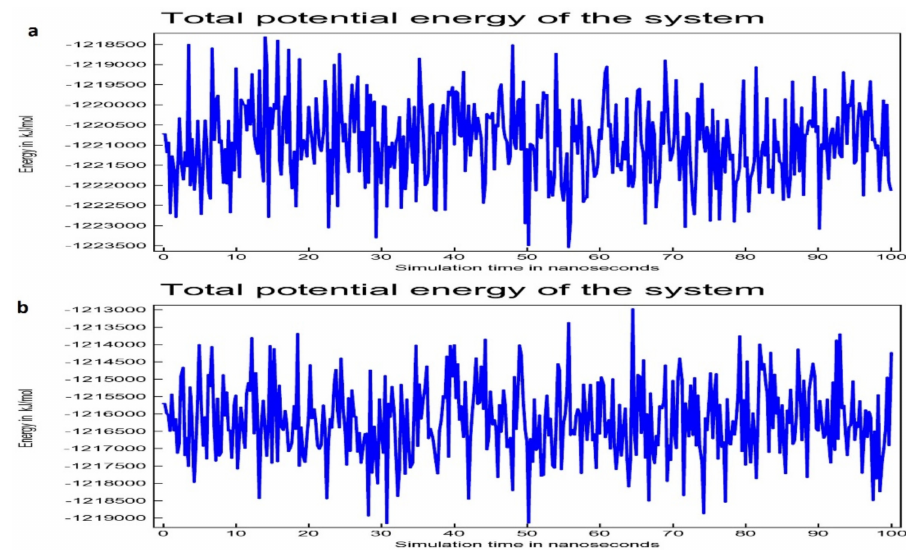
Figure 3. Plot of total potential energy of the system for ( a ) DTQ-3CLpro complex ( b ) DTQ-NSP15 complex versus simulation time of 100 ns.